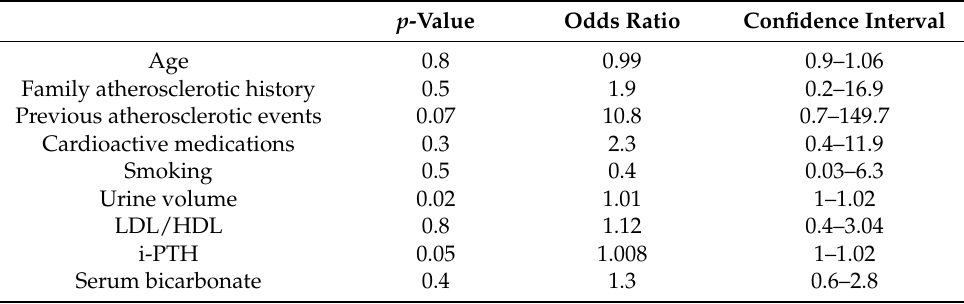
Table 3. Cox-regression analysis for the prediction of diastolic dysfunction.